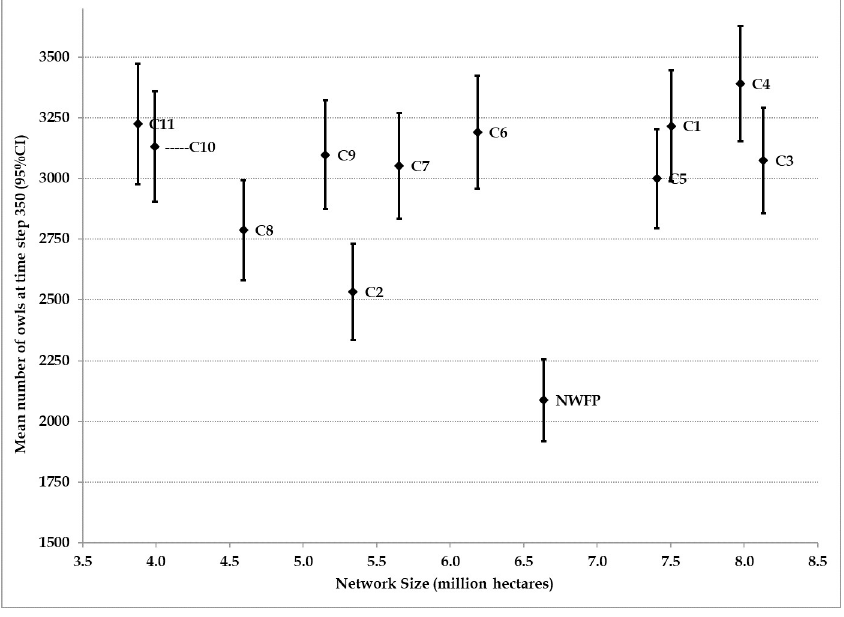
Fig 8. Mean and 95% confidence intervals of simulated northern spotted owl population sizes among 11 composite candidate critical habitat networks and the Northwest Forest Plan (NWFP) size, based on the pessimistic habitat change